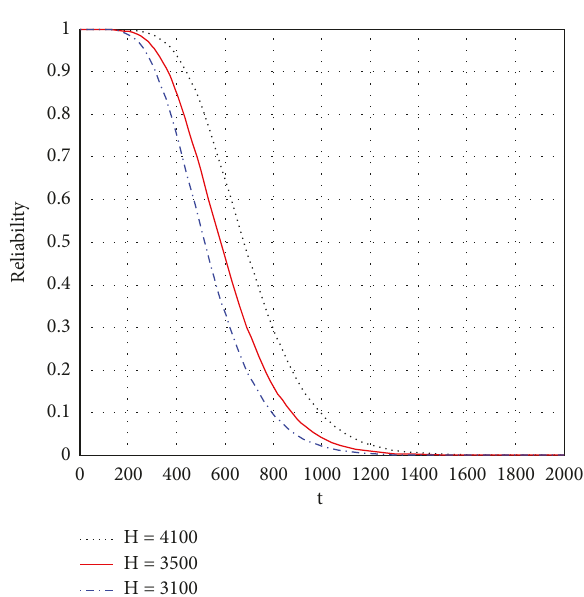
Figure 17: Sensitivity analysis of R ( t ) on H .